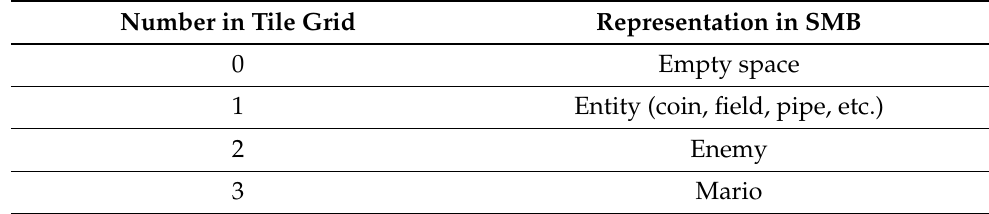
Table 1. Representation of Mario’s